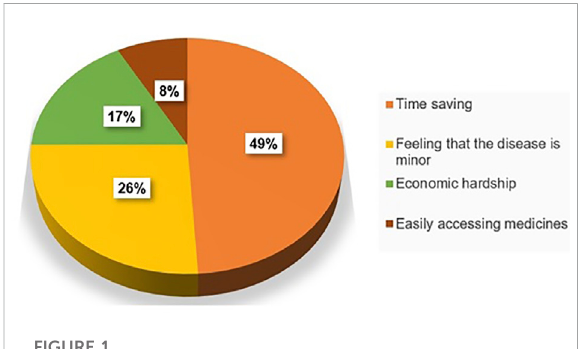
FIGURE 1 Self-medication reasons of study participants, 2019 ( n =